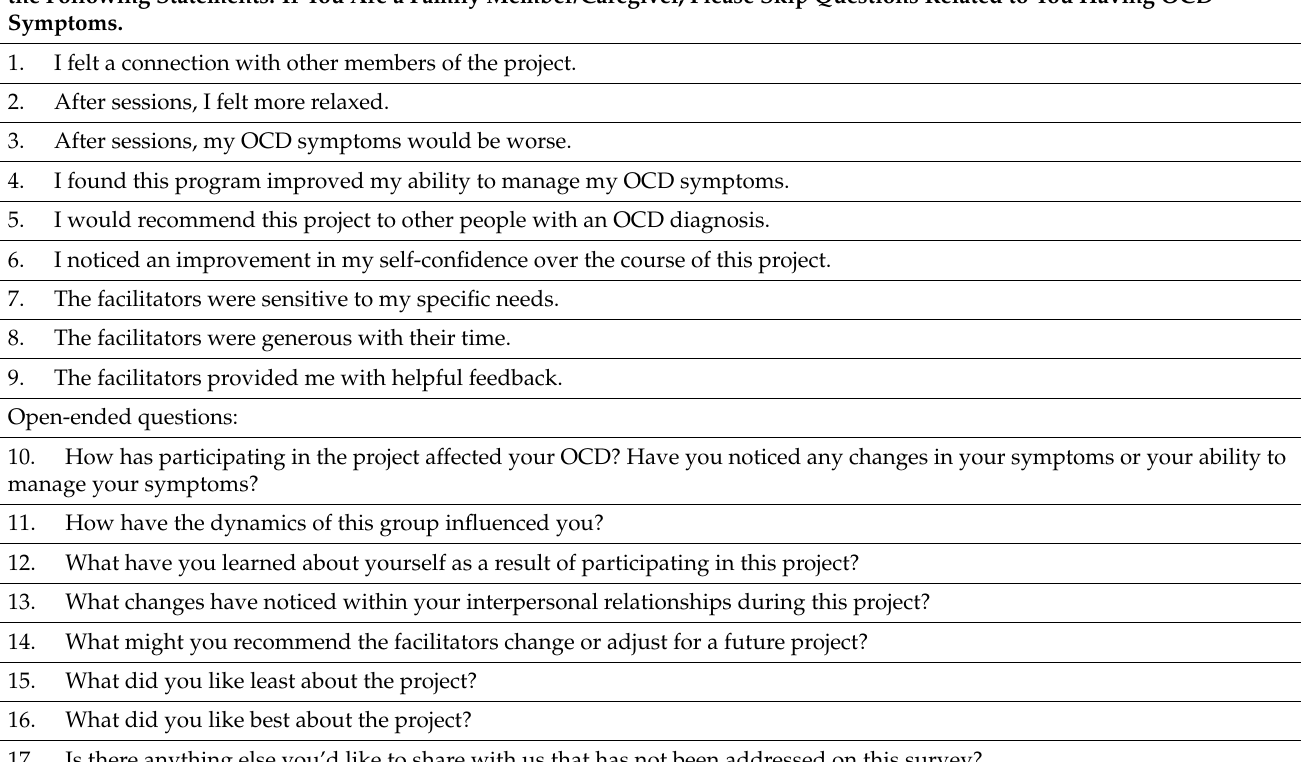
Table 2. Online Qualtrics Survey